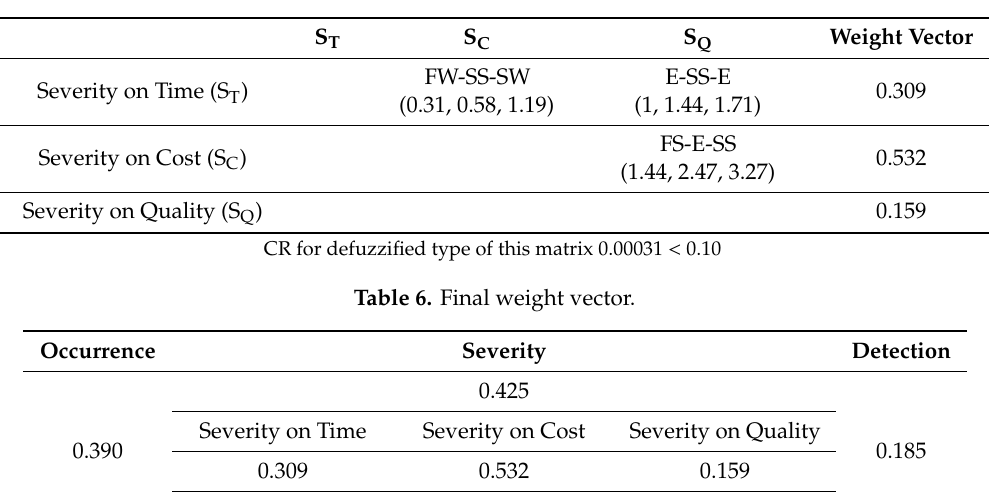
Table 5. Evaluation of experts in second level of risk assessment factors.